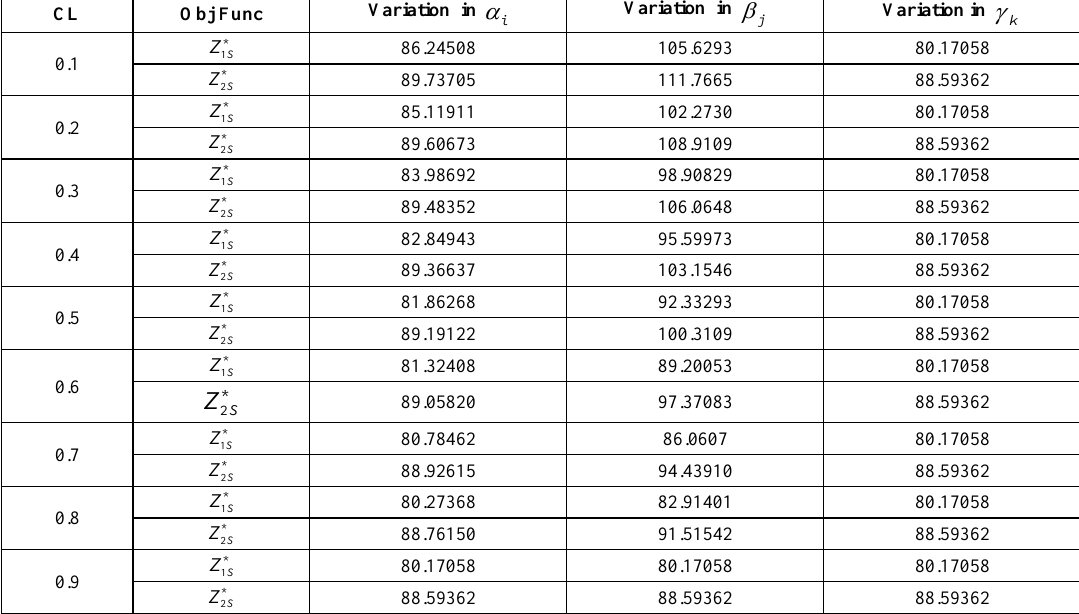
Table 4. Objective values obtained during the sensitivity analysis of model (7.2.1) with